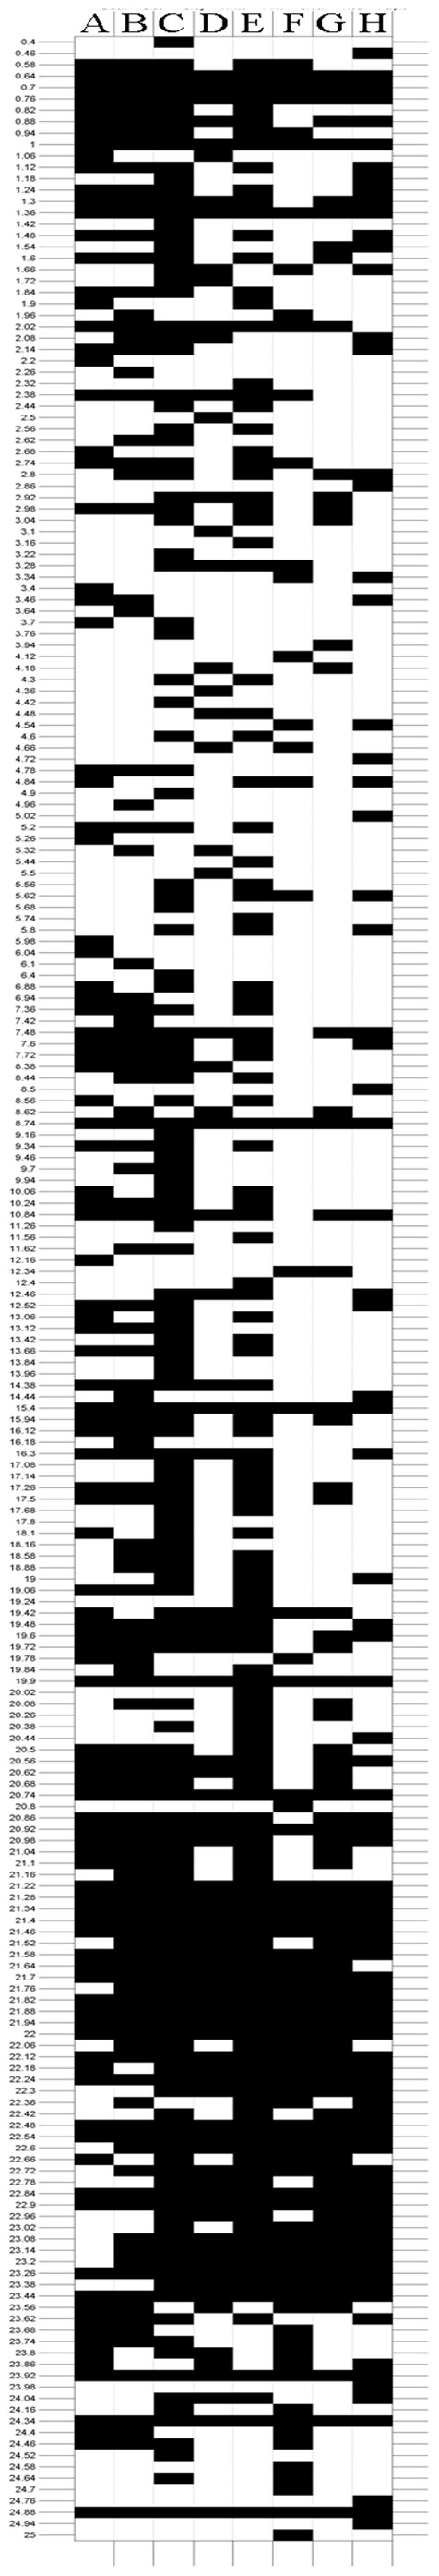
Binary plot illustrating the GC-FID chromatographic peaks (metabolites) associated with each SPME fiber.Columns represent the fibers while rows indicate peak retention times. Each extraction was performed in duplicate and replicates combined. Fiber legend: A - 75 µm CAR-PDMS, B - 85 µm CAR-PDMS, C - 50/30 µm CAR-DVB-PDMS, D - 85 µm PA, E - 65 µm DVB-PDMS, F - 7 µm PDMS, G - 100 µm PDMS, H - 60 µm PEG.